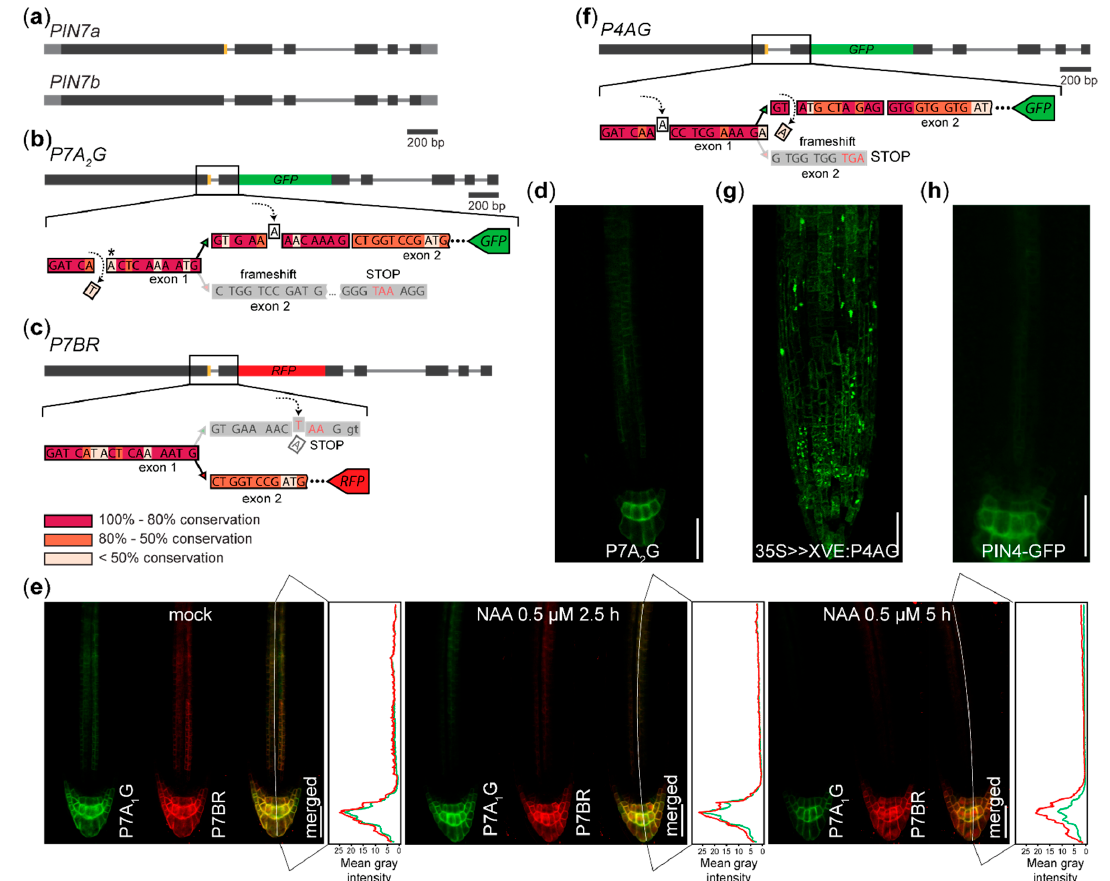
Figure 2. Reporters visualizing AS of PIN7 and PIN4 in the root tip: ( a ) Diagram of the coding regions of the PIN7 gene. The canonical PIN7b isoform differs from PIN7a in the presence of the 12 nucleotide region (orange). ( b ) Scheme of the P7A 2 G reporter for visualizing the PIN7a isoform. Removing the nucleotide prior to the alternative splice site leads to a frameshift in the PIN7b transcript. The frame is restored by insertion of the nucleotide into the region exclusively encoded in the P7A 2 G sequence following the alternative splice site. Asterisk: a neighboring A nucleotide is removed in the P7A 1 G sensor [10] ( c ) The P7BR reporter, as outlined in [10]. The visualization of P7BR is accomplished by introducing the termination codon into the protruding region encoded entirely by PIN7a. P7AG and P7BR are encoded by two constructs that are separately transformed and then crossed. ( d ) Expression pattern of the P7A 2 G reporter. ( e ) Following the treatment with the synthetic auxin NAA, a differential decrease of expression is observed in the root columella cells, while nearly no difference in their expression change is observed in the vascular cylinder. ( f ) Scheme of the P4AG reporter for visualizing the PIN4a isoform ( PIN4 shows an identical exon / intron structure with PIN7 [16]). Following the induction of the 35S >> XVE:P4AG transgene, the GFP fluorescence is also seen outside ( g ) the PIN4:PIN4-GFP expression domain ( h ). Bars, 100 µ m on ( e ), ( d ), ( g ) and ( h ). Black—coding regions, grey—UTRs, thin grey line—introns, yellow—regions modified by AS, red—RFP, green—GFP on ( a ), ( b ), ( c ) and ( f ). The color shading of the evolutional conservation code outlined ( c ) was assessed as a percentage of the preserved nucleotides on the alignment of the PIN7 -like sequences within the Brassicaceae